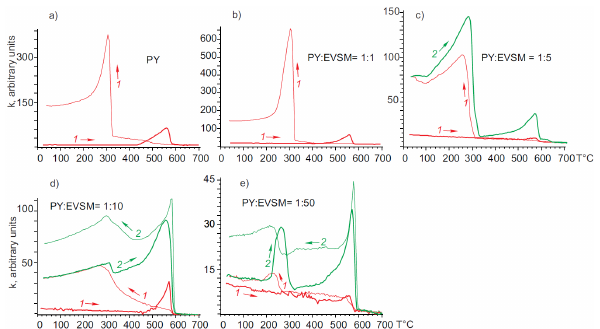
Fig. 11. Susceptibility versus temperature curves of pyrite and vi- vianite mixtures. The arrows and cursive numbers indicate the heat- ing and cooling runs. PY – pyrite, EVSM –